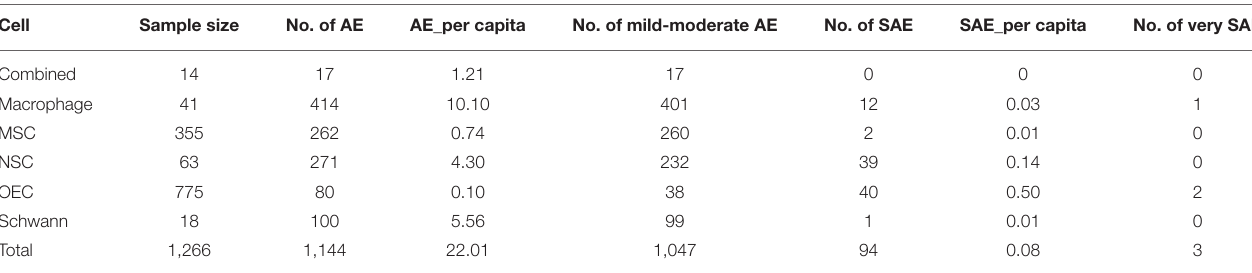
TABLE 4 | Adverse events of different transplanted cells.